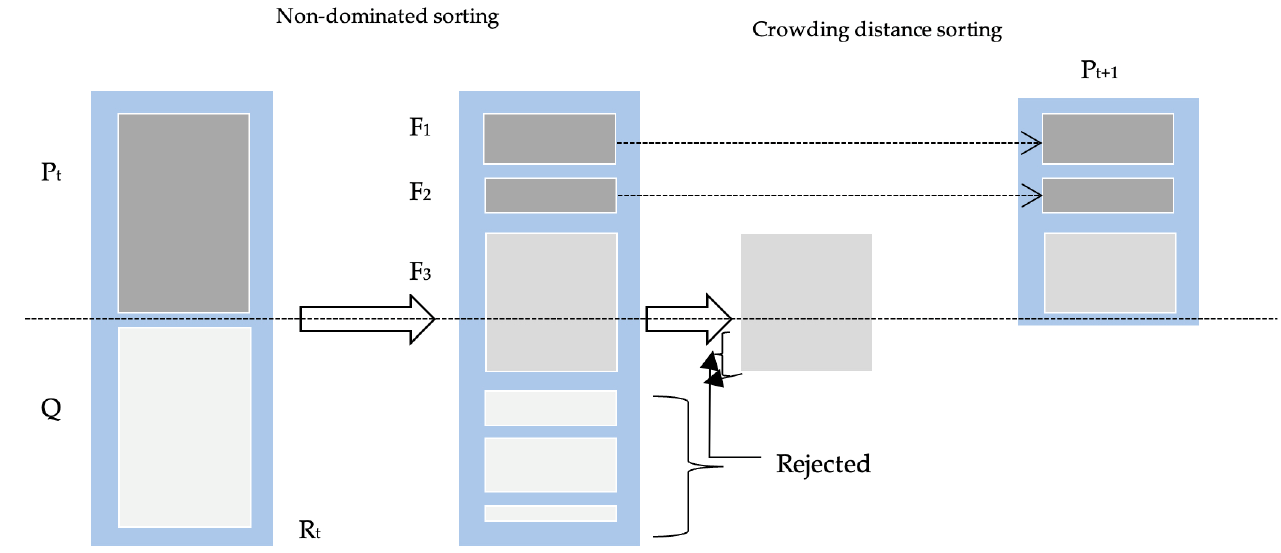
Figure 2. Non dominated selection [28]; R t = P t ∪ Q t is the total population, F i is the non-dominated set, and P t + 1 is the chosen subsequent nondominated